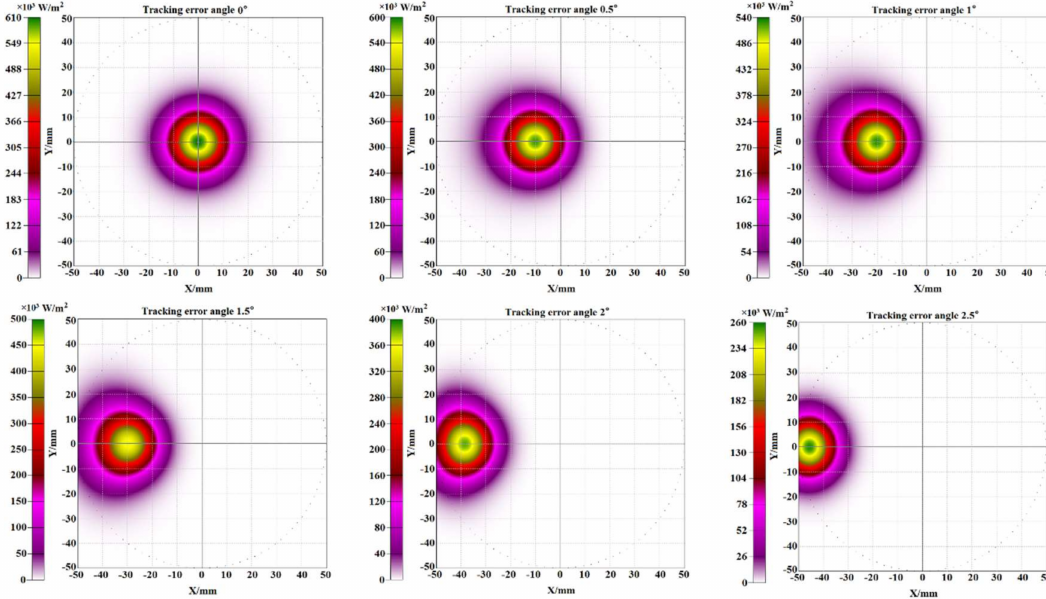
Figure 10. The flux density distributions of the focal spots for various tracking error